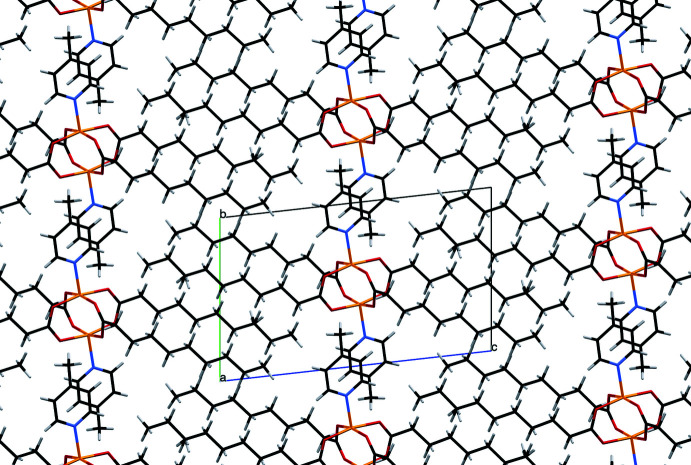
Packing of [Cu2(μ-O2CC9H19)4(4-Mepy)2] viewed along the a axis (disorder not shown)